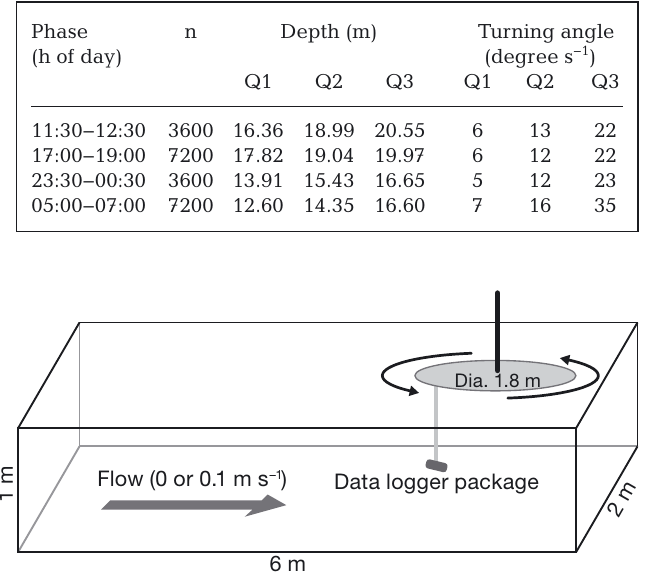
Fig. 1. Schematic illustration of the flume tank